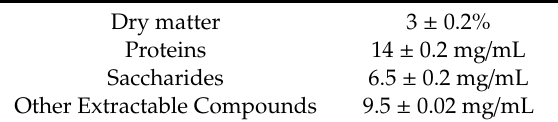
Table 1. Dry matter, protein, saccharide, and other extractable compound content of Flaxseed Oil Cake Extract